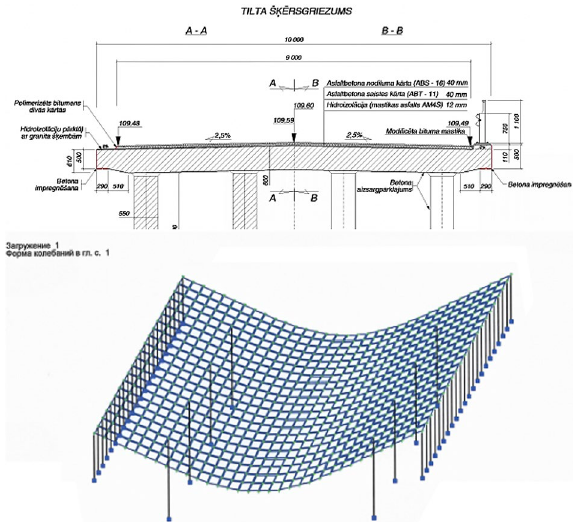
Fig. 13. Cross section and first mode shape of a bridge